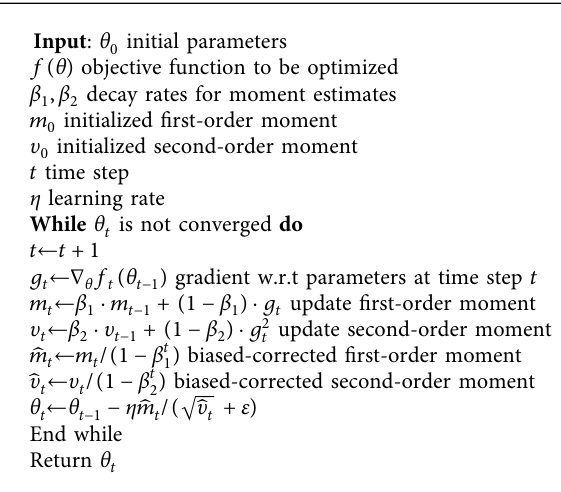
Q Q a , b , and c on the low voltage side.